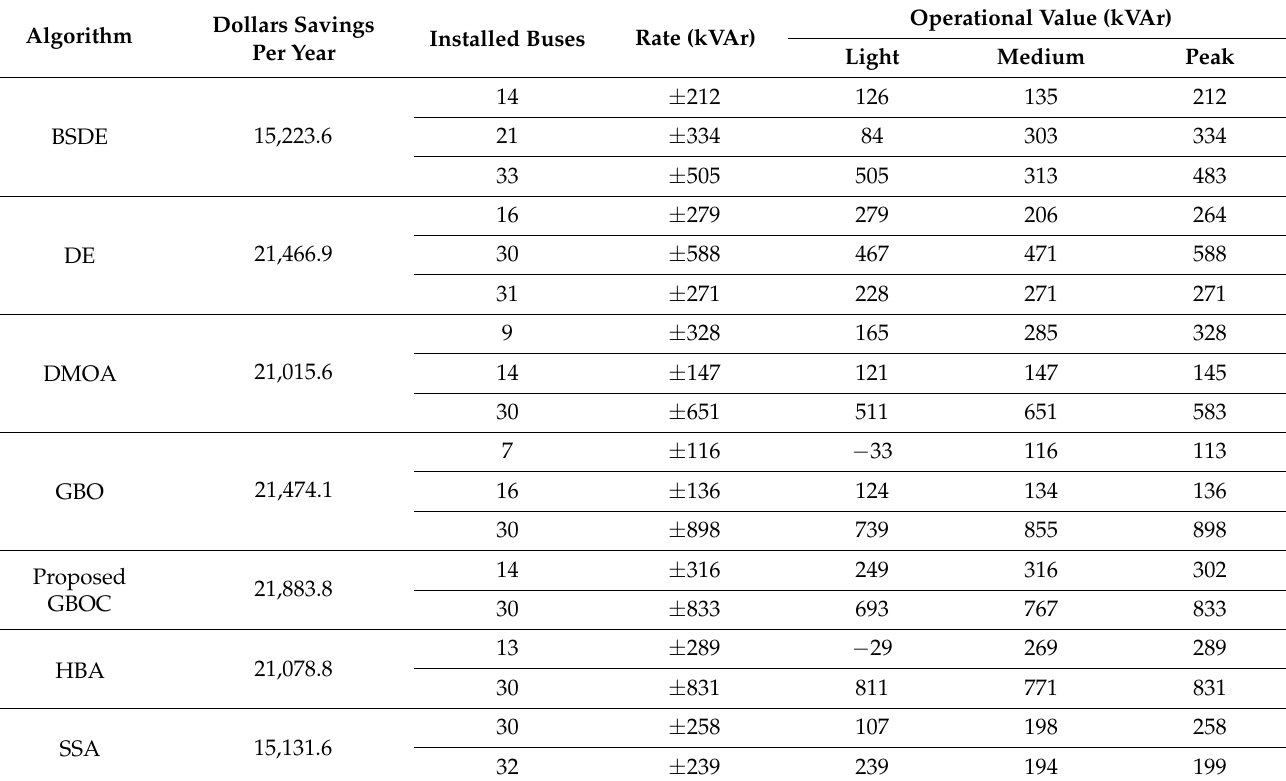
Figure 5. Minimum voltages for the IEEE 33-distribution system of the GBOC versus GBO, SSA, DMOA, DE, and HBA for Scenario 1. Table 1. Placement and sizing of D-SVC devices for the IEEE 33-distribution system for Scenario